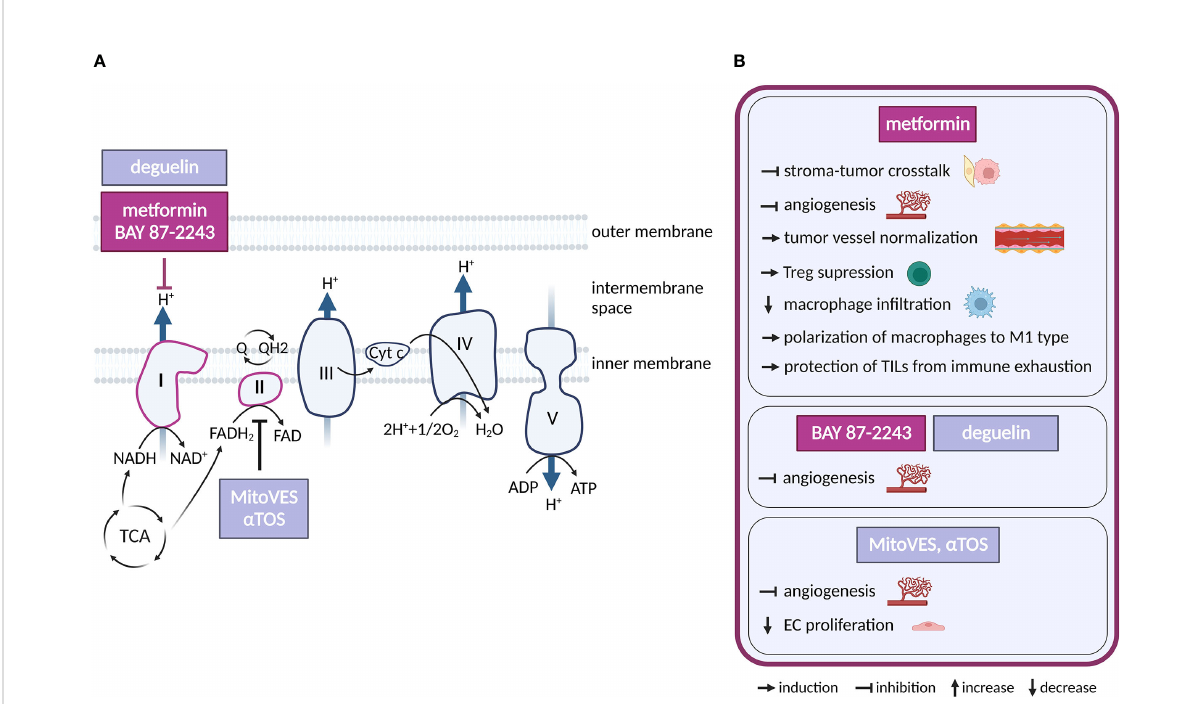
FIGURE 3 Inhibitors of oxidative phosphorylation and their effects on TME cell types. (A) Schematic representation of the OXPHOS system. Only inhibitors with a reported effect in the TME are shown. Inhibitors tested in clinical trials for cancer and in clinical practice are highlighted in dark violet, those in preclinical studies are in light grey-blue. (B) Effects of the OXPHOS inhibitors shown in (A) on cell populations present in the